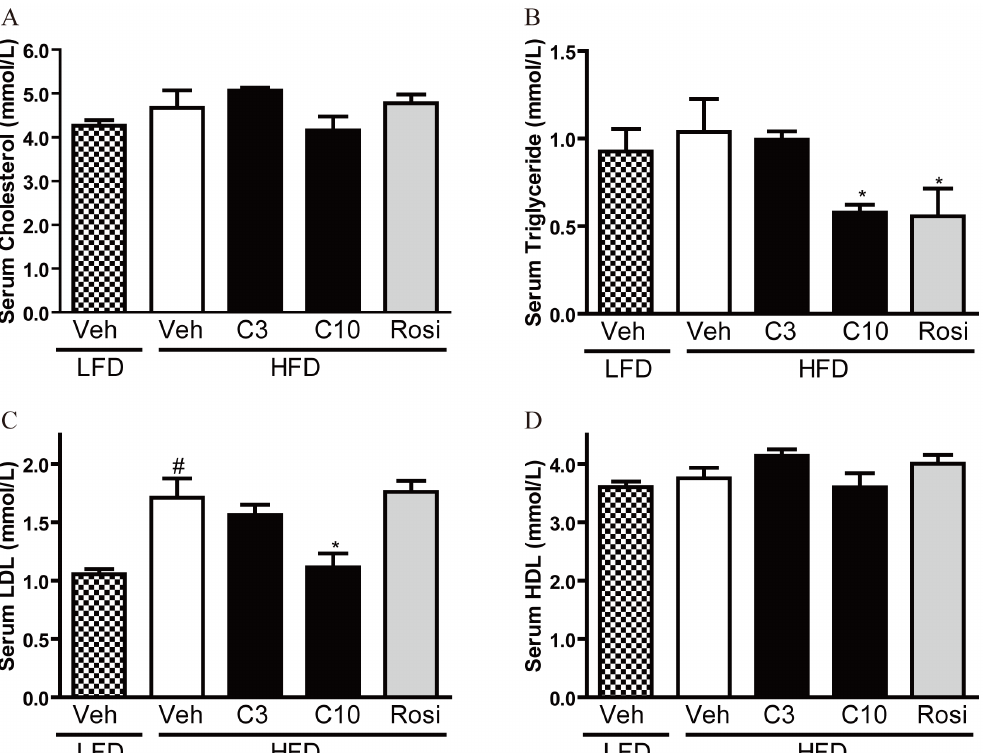
Figure 5. CMHX008 protects HFD induced dyslipidaemia. C57BL/6 mice were fed with HFD or LFD for 16 weeks. Then HFD fed C57BL/6 mice were treated with CMHX008 (3 and 10 mg/kg, HFD-C3 and HFD-C10), rosiglitazone (3 mg/kg, HFD-Rosi) or vehicle (HFD-Veh or LFD-Veh) only, for additional 5 weeks. Trunk blood was collected at the end of the experiment. Serum was used for the measurement of cholesterol (A), triglyceride (B), low-density lipoproteins (LDL, C) and high-density lipoproteins (HDL, D). Data are the means 6 S.E.M., n=4–5; # P , 0.05 vs LFD-Veh and * P , 0.05 vs HFD-Veh.